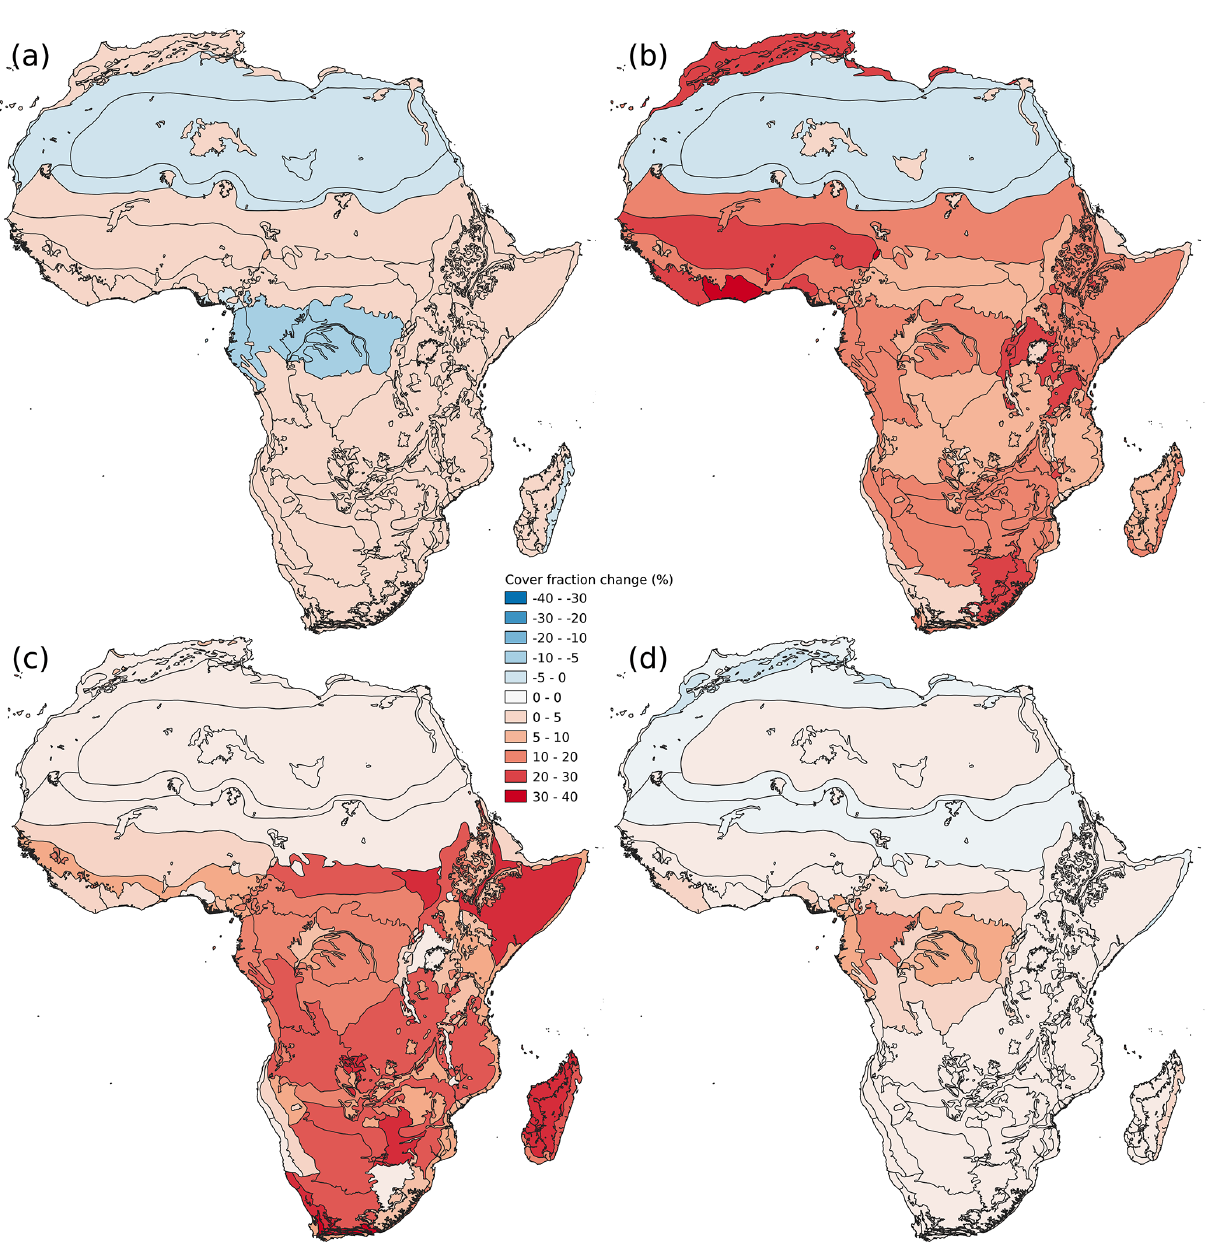
Figure 3. Uncertainty in CWT constrained by an AGB map. Absolute change in forest (a) and bare soil (b) cover fraction (%) between the 2.5th and 97.5th percentile PFT maps. High values represent a large uncertainty in the estimation of the true cover fraction. Panels (c) and (d) represent disagreement estimated as the difference between the CWT based on expert knowledge and the CWT constrained by an AGB map. Disagreement in forest (c) and bare soil (d) is expressed as absolute change (%). High values represent a strong disagreement between the two methods. Black lines delimit the different ecoregions according to Olson et al. (2001).